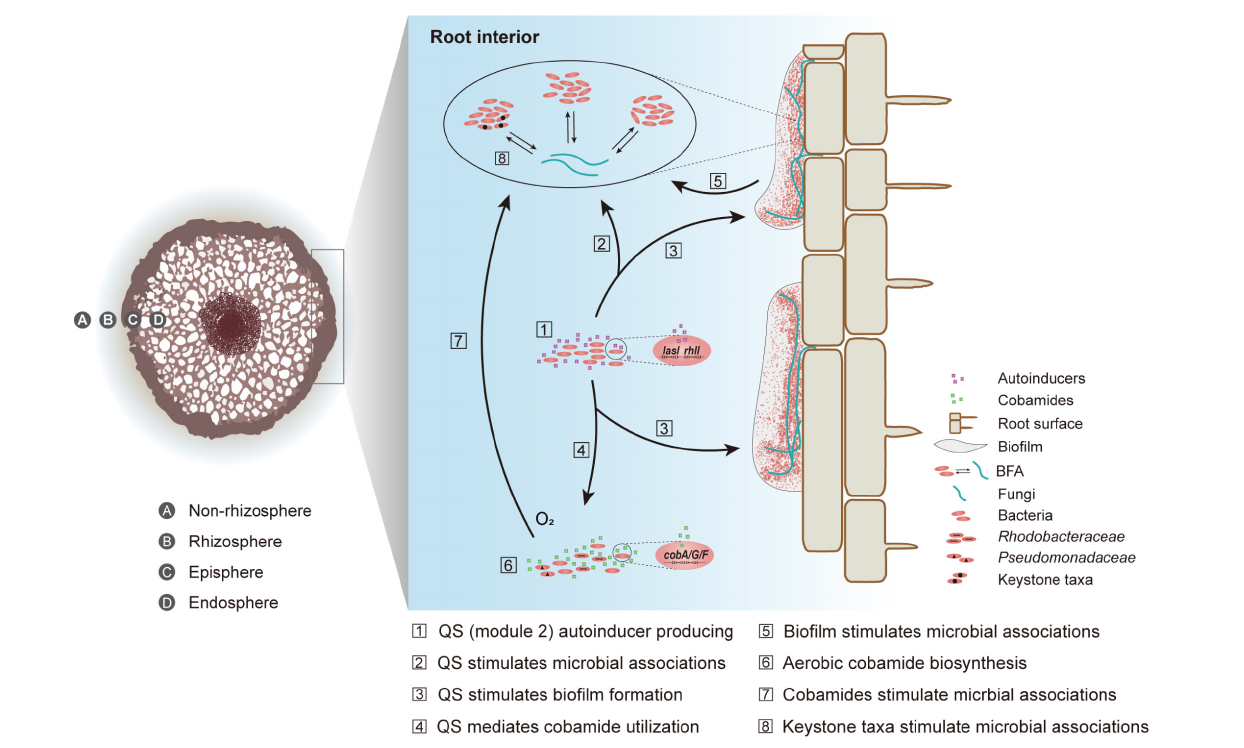
FIGURE 6 | A conceptual model of the intensified bacterial-fungal association (BFA) in root interior. Quorum sensing is abbreviated to QS.